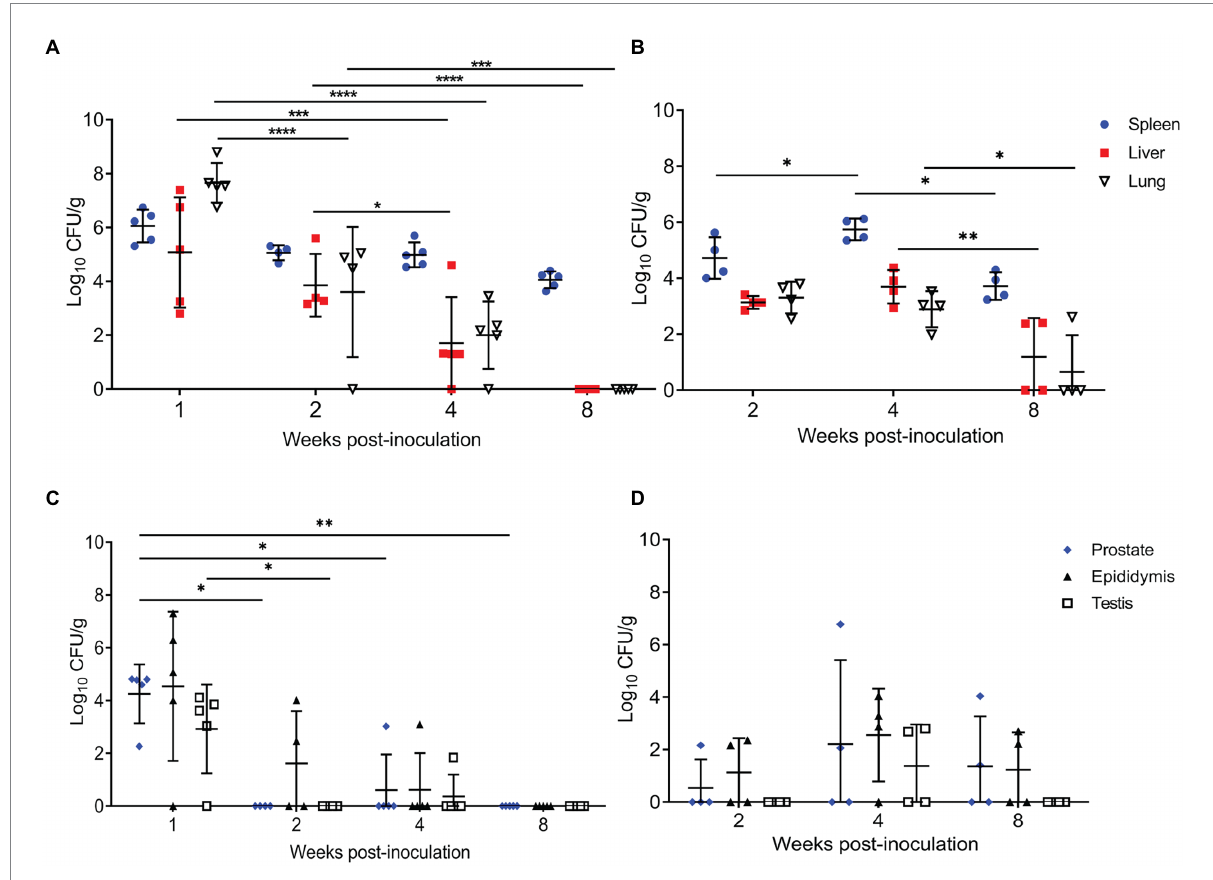
FIGURE 1 Intratracheal inoculation results in colonization of the spleen, liver, lung, and reproductive organs in mice and guinea pigs. (A) Spleen, liver, and lung were collected from mice ( n = 5/time point) inoculated with 1×10 7 CFU/25 μ l via intratracheal inoculation and euthanized at 1-,2-,4-, and 8-weeks post-challenge. (B) Spleen, liver, and lung were collected from guinea pigs ( n = 4/time point) inoculated with 1×10 7 CFU/50 μ l via intratracheal inoculation and euthanized at 2-,4-, and 8-weeks post-challenge. Epididymis, testicle, and prostate were collected at the same time points in mice (C) and guinea pigs (D) . Differences in mean colonization between time points analyzed by 2-way ANOVA followed by Šídák’s multiple comparison test. Horizontal bar indicates mean colonization. Results reported as log 10 CFU/g with S.D. ** p < 0.01, *** p < 0.001, **** p <